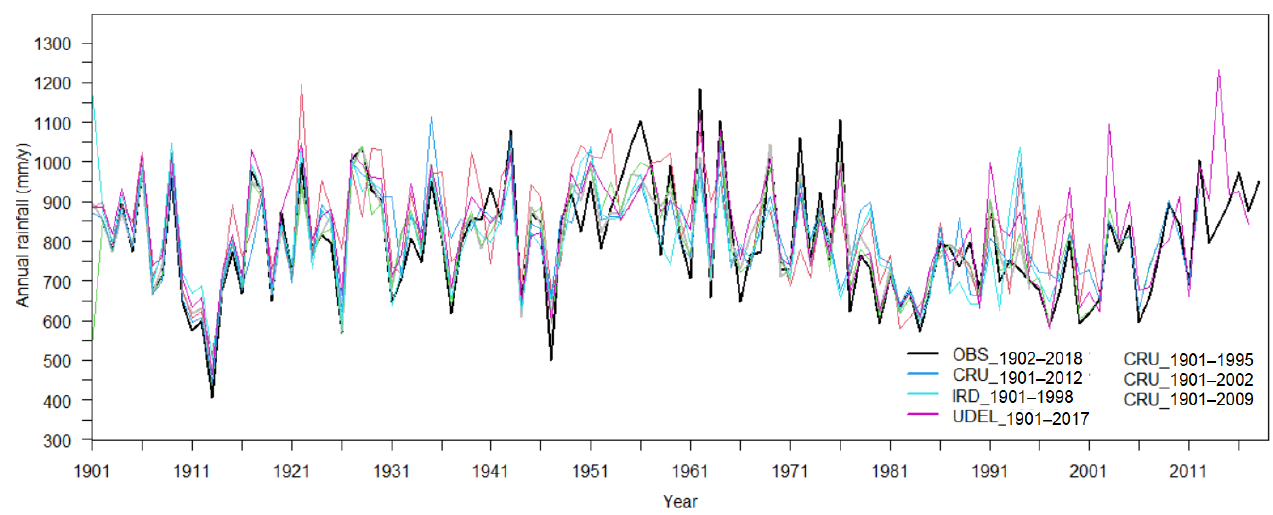
Figure 2. Annual rainfall amount at Ouagadougou station from the different sources. The correlation coefficients and the mean absolute errors are computed at each sta- tion with the covering mesh (gridded data). Figure 3 presents the whisker boxes of the 34 correlation coefficients. Three boxes (CRU_1995, IRD_1998 and UDEL_2017) are above the